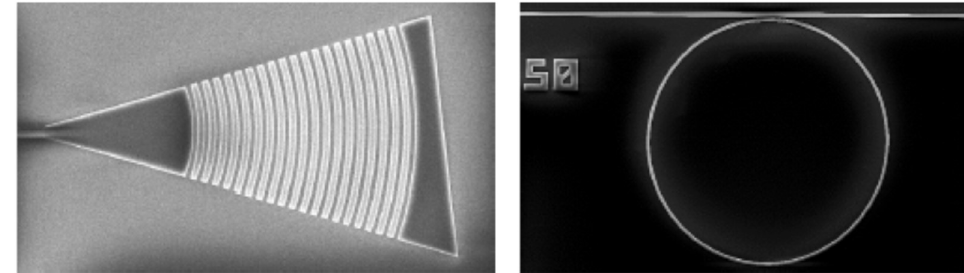
Figure 3. SEM images of silicon nitride grating coupler (left) and ring resonator (right).